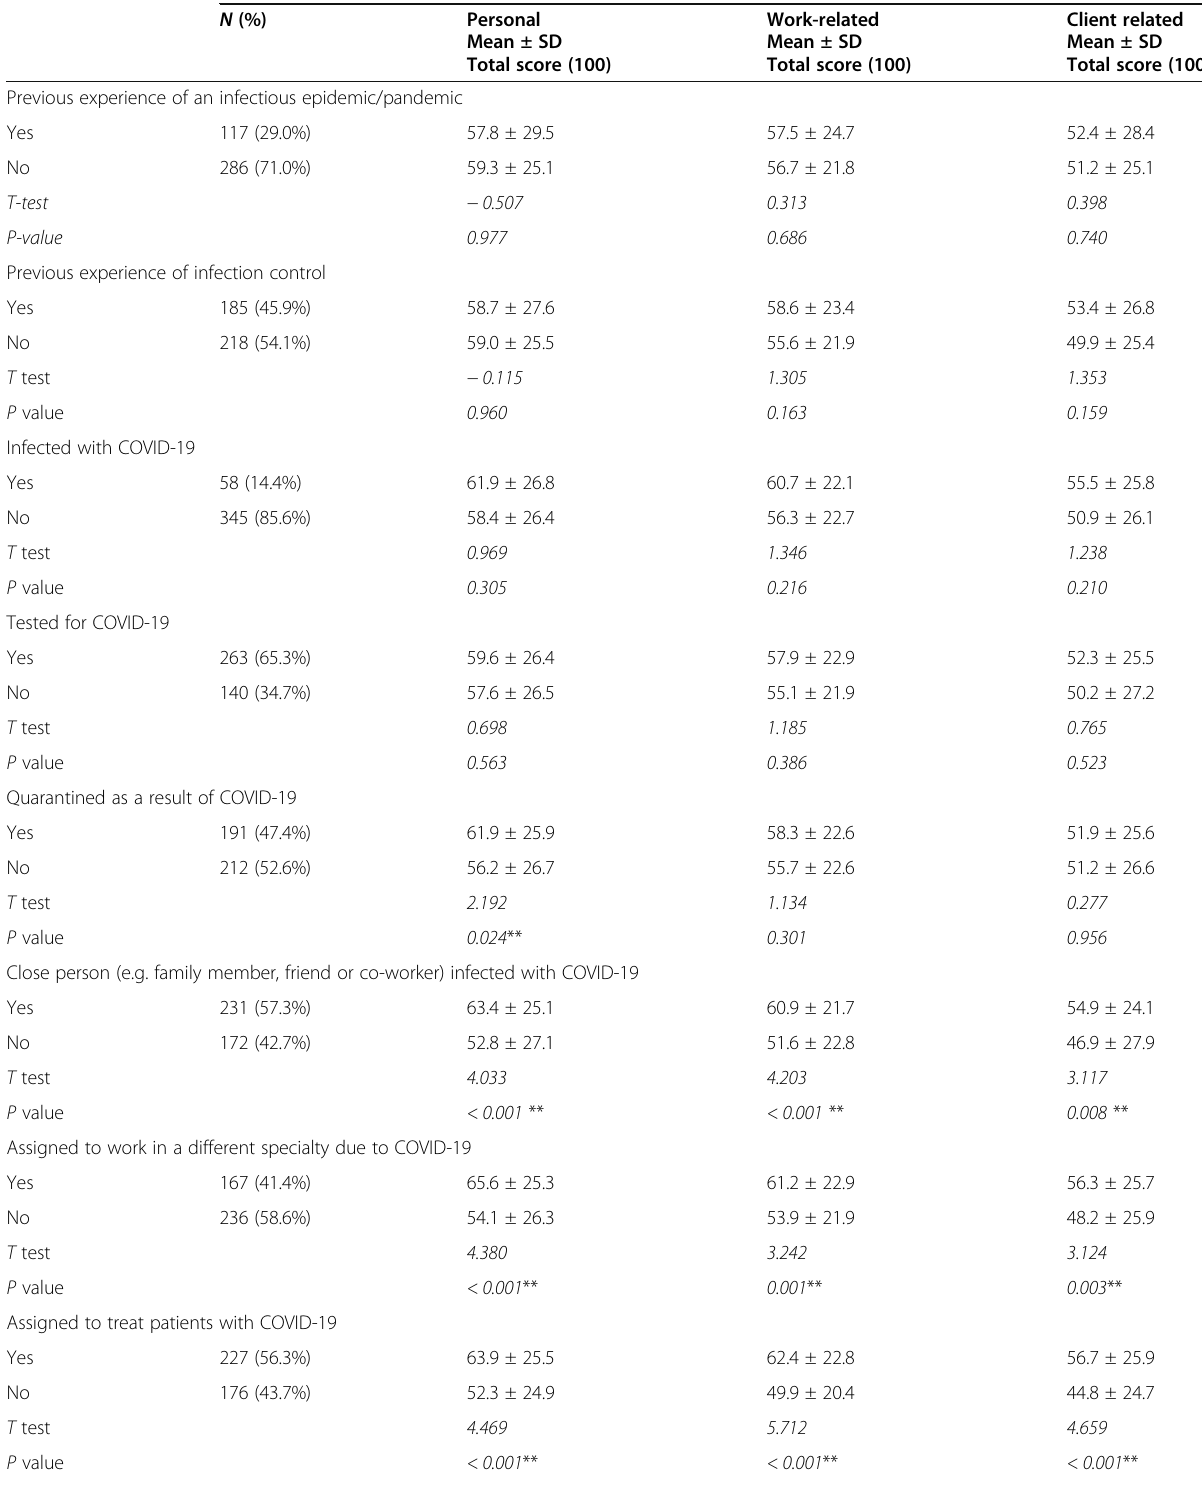
Table 4 Respondents ’ experiences during the COVID-19 pandemic ( n = 403) and statistical associations between the CBI